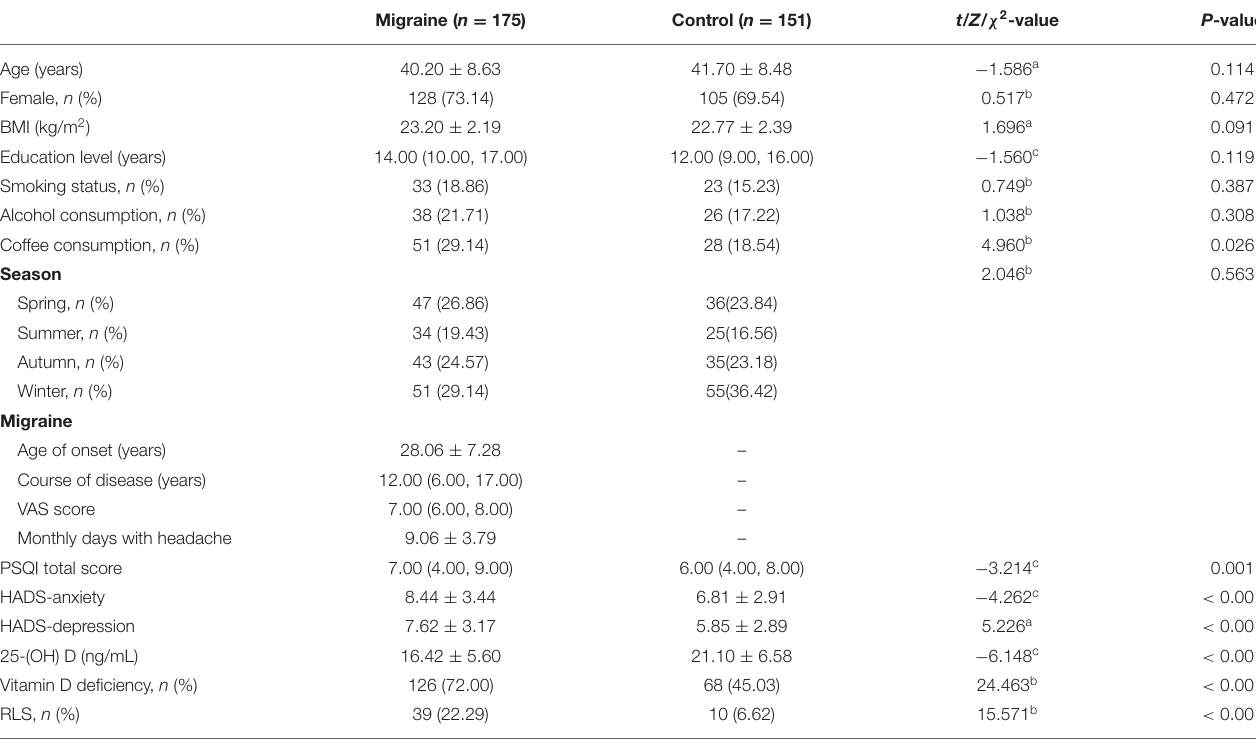
TABLE 1 | Clinical data and vitamin D levels between migraine group and control group.